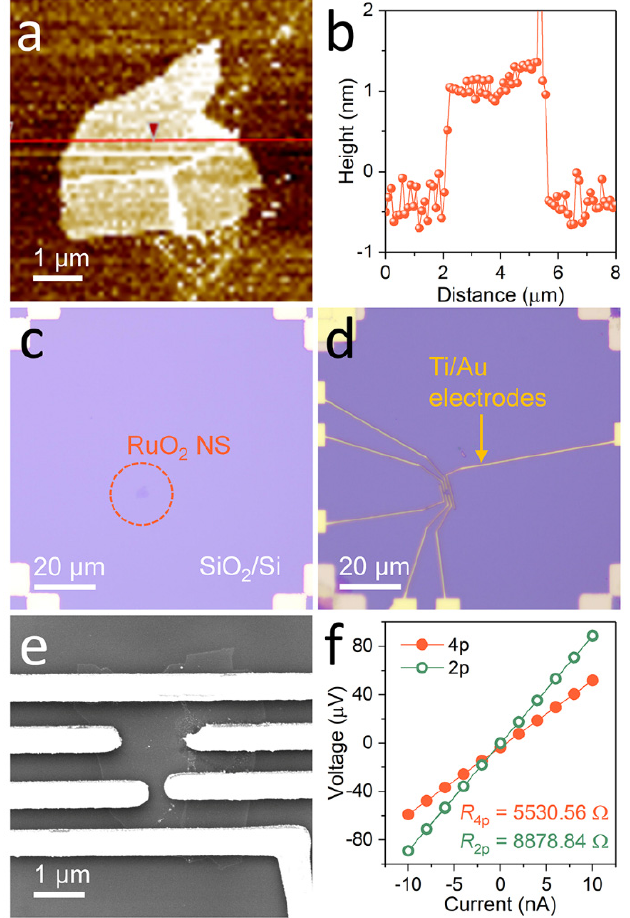
Figure 2. Device fabrication and four-point probe measurement. ( a , b ) Atomic force microscopy (AFM) image and height profile of a monolayer RuO 2 nanosheet. ( c , d ) Optical microscopy (OM) images of the nanosheet ( c ) before and ( d ) after metallization process. ( e ) Scanning electron microscopy (SEM) image of the nanosheet device with four terminals. ( f ) I – V curves obtained from the monolayer RuO 2 nanosheet using the four- (closed orange circles) and two-point probe (open green circles) measurement techniques. All images and data were obtained from the same nanosheet.